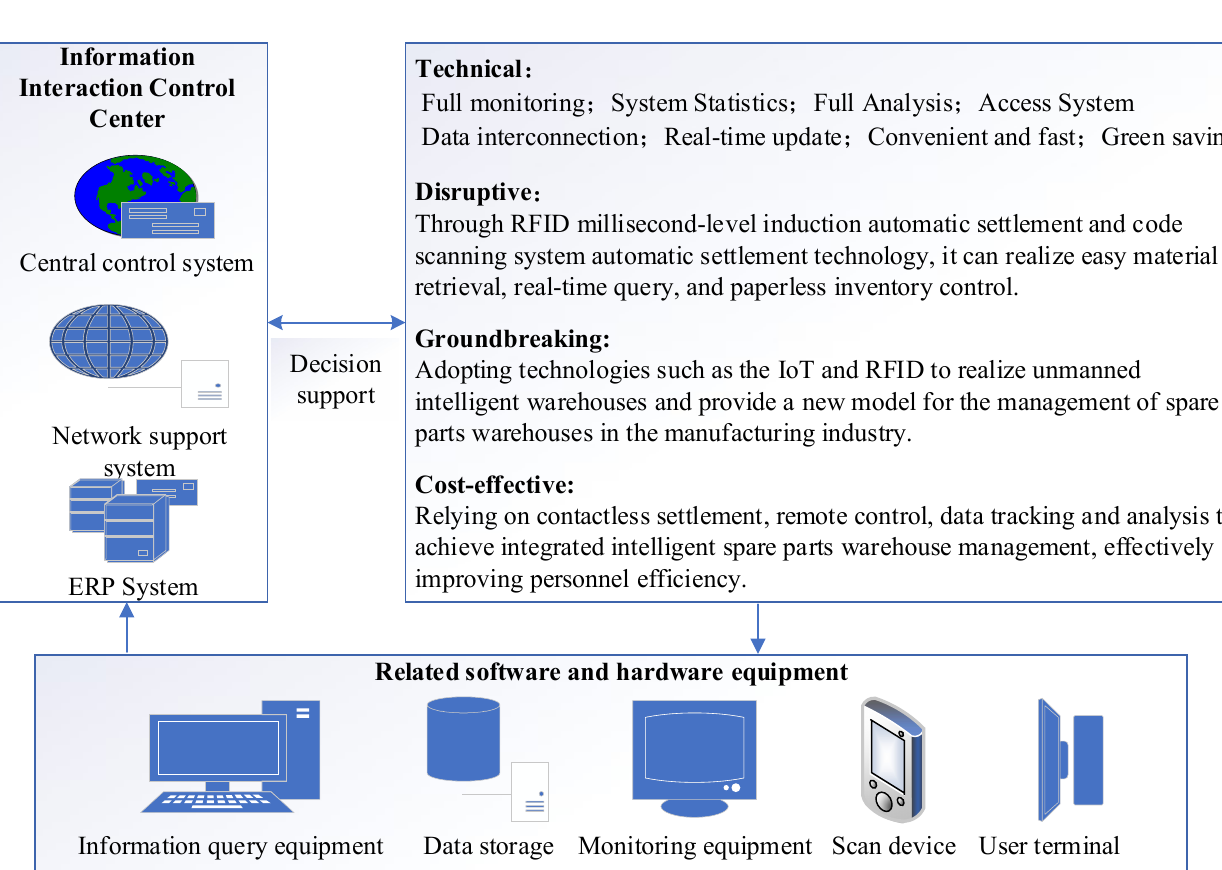
Figure 8. Spare parts management for complex product manufacturing system